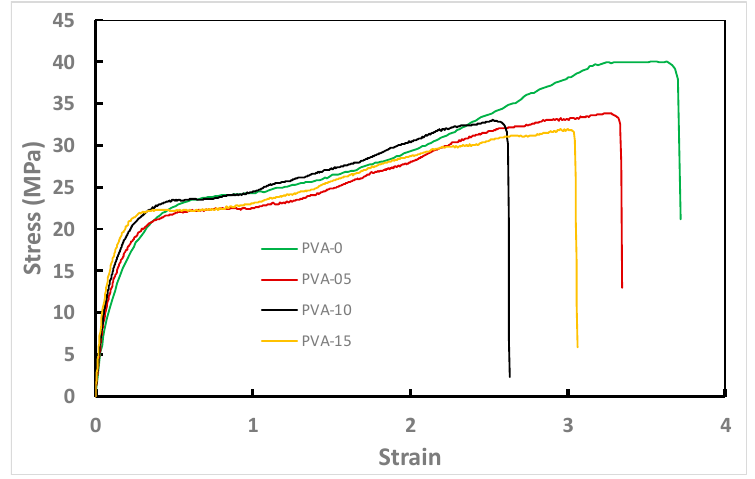
Figure 9. Typical stress–strain plots of PVA materials with different nano-clay content. All films were crosslinked at 135 °C for 45 min.